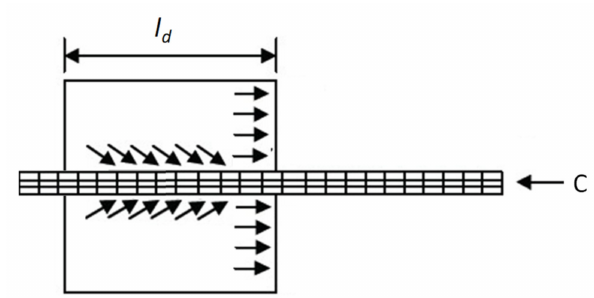
Figure 16. Rebar force transition structure [57].